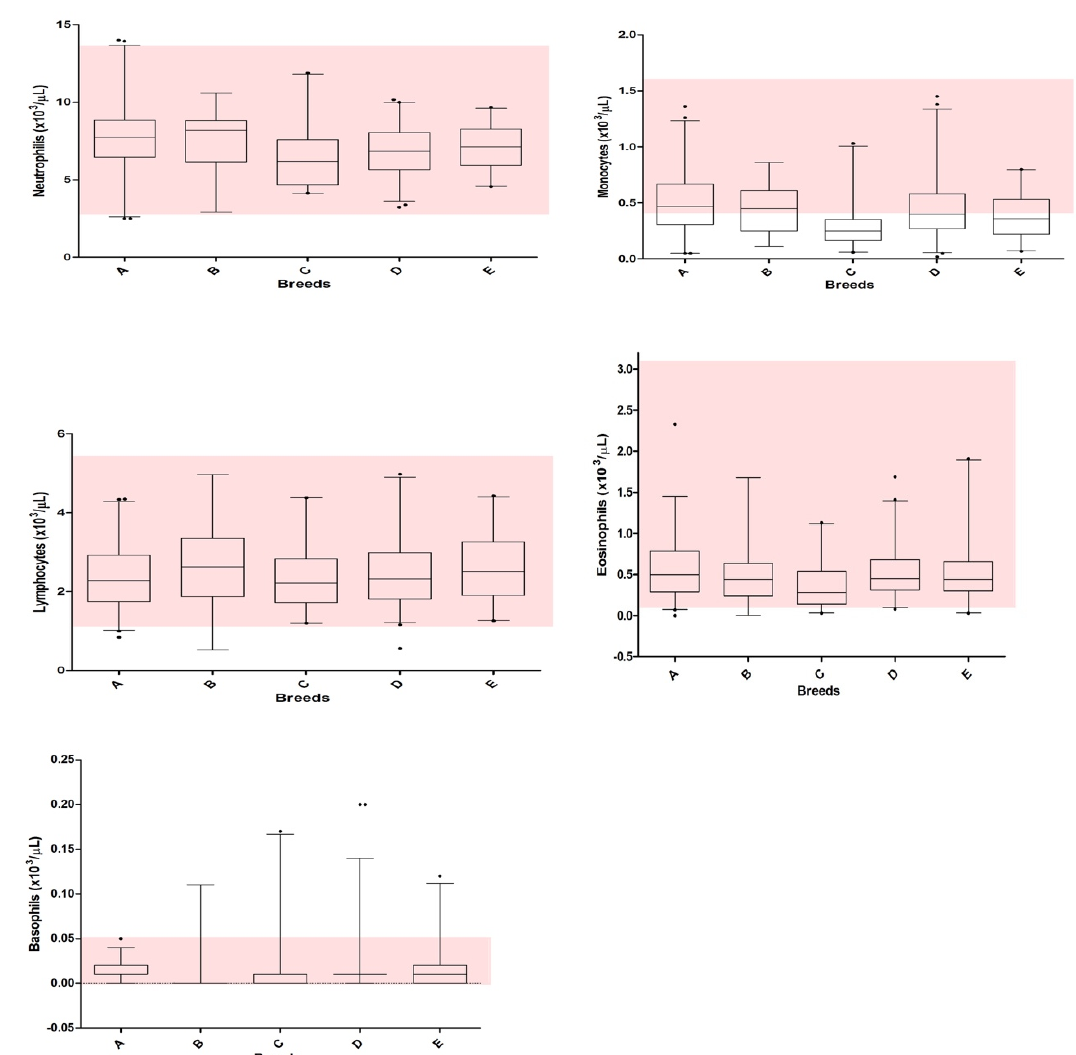
Figure 1. Hematological results recorded in the 5 breeds of dogs included in this study (156 Ariégeois–A, 52 Bleu de Gascogne–B, 64 Bracco italiano–C, 123 Segugio italiano–D, 50 Briquet Griffon Vandeen–E). The boxes represent the lower quartile, median, and upper quartile, and the whiskers represent the minimal and maximal values. The small points indicate outliers (i.e., values exceeding quartiles). The gray area indicates the reference intervals reported for hematological data (claimed RIs). (WBC = white blood cells; RBC = red blood cells; MCV = mean corpuscular volume; Hb = hemoglobin; HCT = hematocrit, MCHC = main corpuscular hemoglobin concentration; RDW-SD = red cell distribution width).